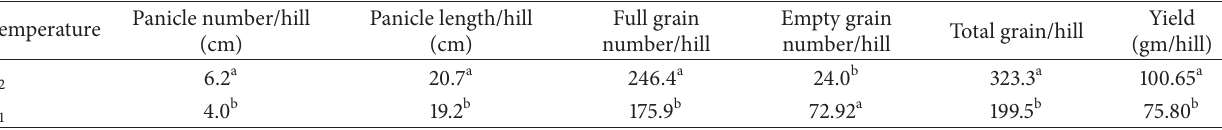
Table 3: Temperature effect on yield and yield components across varieties.